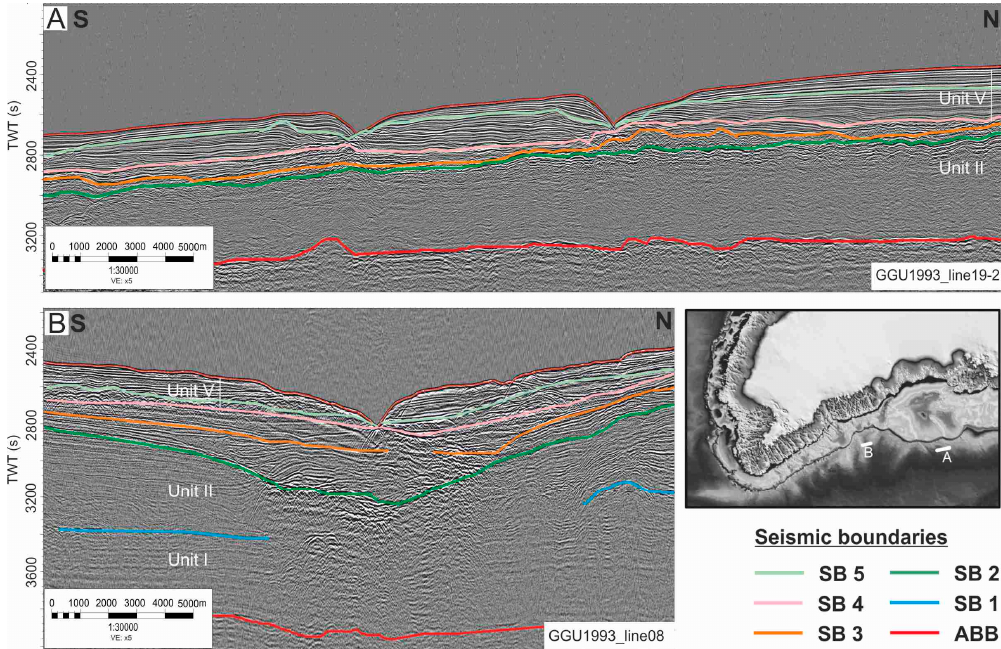
Figure 6. ( A and B ) : Two along-slope seismic profiles visualising the two types of channels present in the study area. The small map inset indicates the location of the seismic lines.